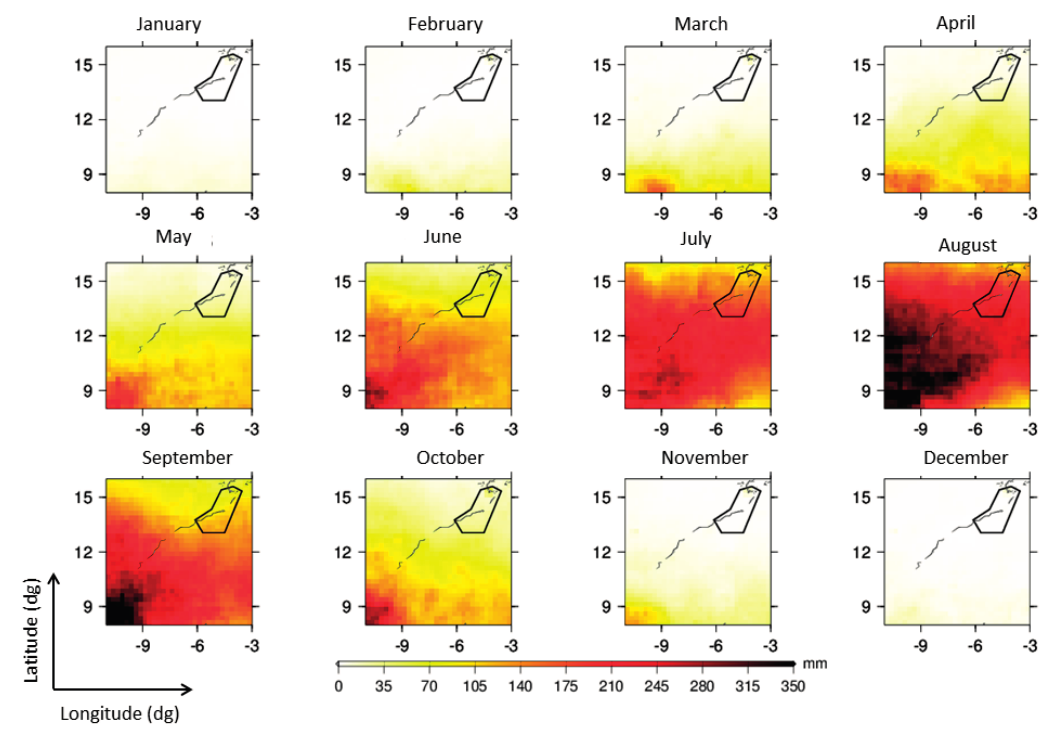
Figure 11. Maps on monthly average precipitation from Tropical Rainfall Measuring Mission (TRMM)